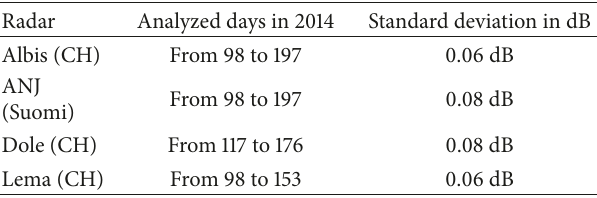
Table 3: Agreement between the daily horizontal and vertical polarization solar signals as retrieved by four dual-polarization